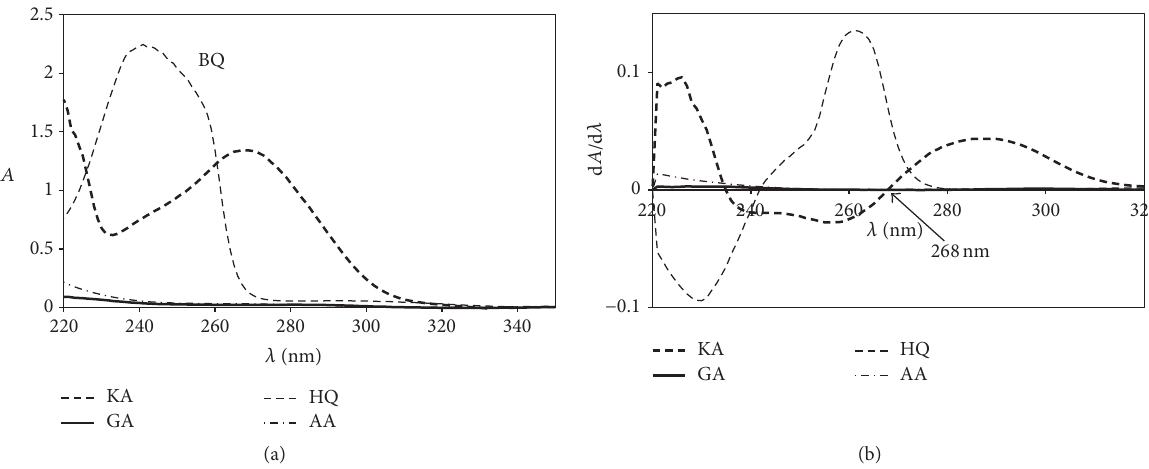
Figure 5: Overlaid (a) zero-order and (b) first-order derivative spectra of HQ, KA, GA, and AA in the presence of K 2 Cr 2 O 7 in 1mol ⋅ L −1